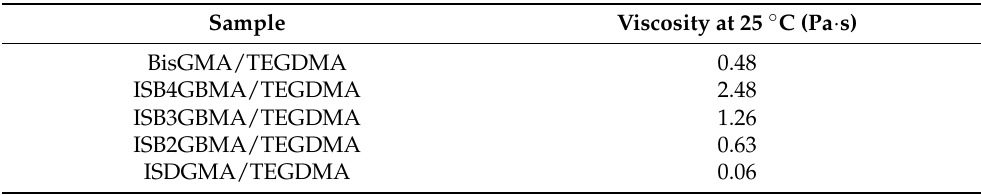
Table 2. Brookfield Viscosity of BisGMA/TEGDMA, ISB4GBMA/TEGDMA, ISB3GBMA/TEGDMA,